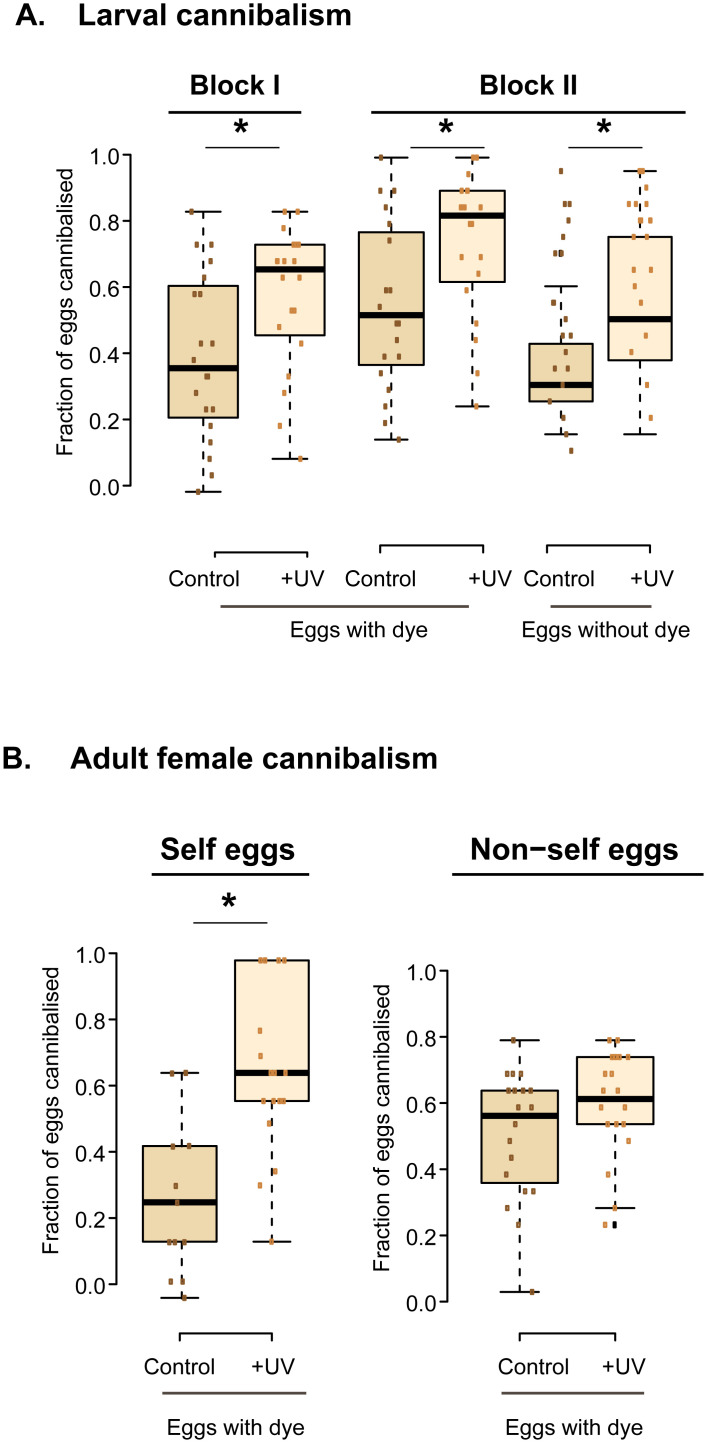
Impact of flour microbes on cannibalism rate.The fraction of eggs eaten by (A) isolated larvae (tested in two independent experimental blocks), and (B) single adult females in untreated (“control”) vs. UV treated wheat flour (n = 20 replicates/treatment). Eggs provided for cannibalism (20 eggs per replicate) were laid by females in flour with vs. without neutral red dye (which colors eggs pink). In panel B, eggs were either provided to the same female (“self eggs”) or a randomly chosen other female (“non-self eggs”). For statistical analysis, see S4 Table.